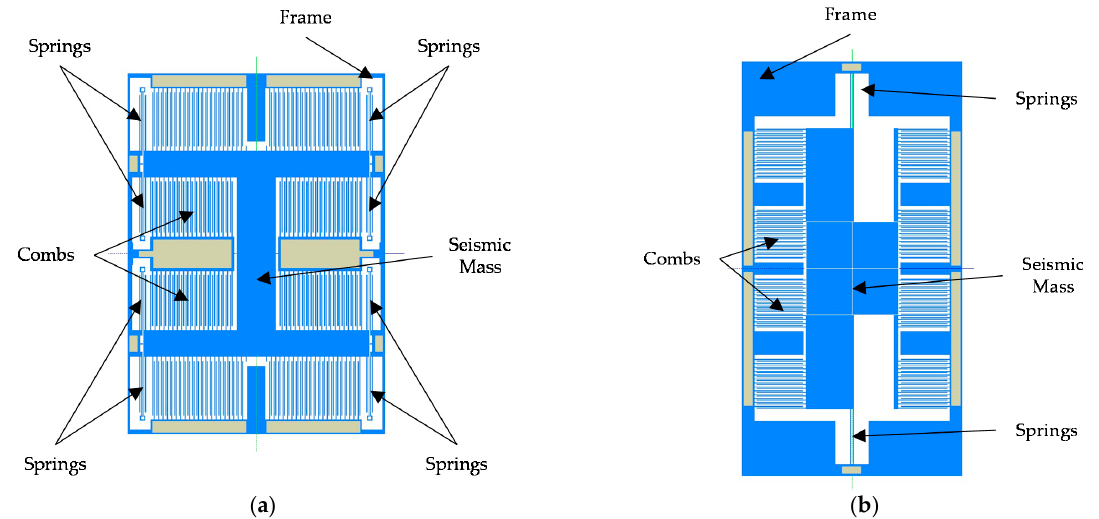
Figure 3. Models of the designed accelerometers: ( a ) X -axis accelerometer; ( b ) Z -axis accelerometer.